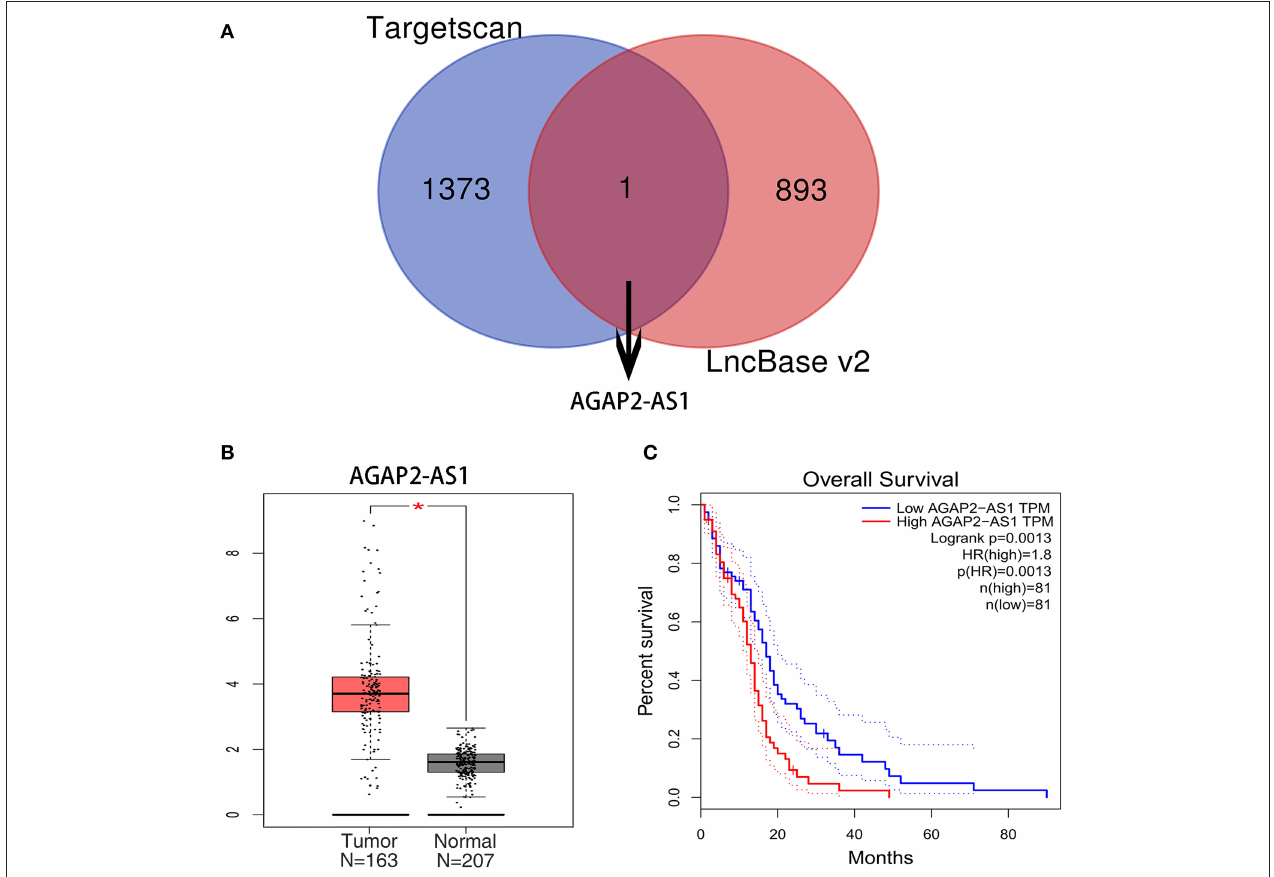
FIGURE 4 | Identification of upstream lncRNAs. (A) The lncRNA targeted by miR-9-5p in the Targetscan and LncBase v2 databases. (B) The expression level of AGAP2-AS1 between GBM and normal samples in the GEPIA database. The asterisk indicates that the difference between the Tumor (GBM) group and the Normal brain tissue group is statistically significant ( P < 0.05). (C) The prognostic value of AGAP2-AS1 in human GBM. TPM is the abbreviation of Transcripts Per Million, which is the standardized statistic used in RNA-SEQ data analysis, and its dotted lines represent the 95% confidence